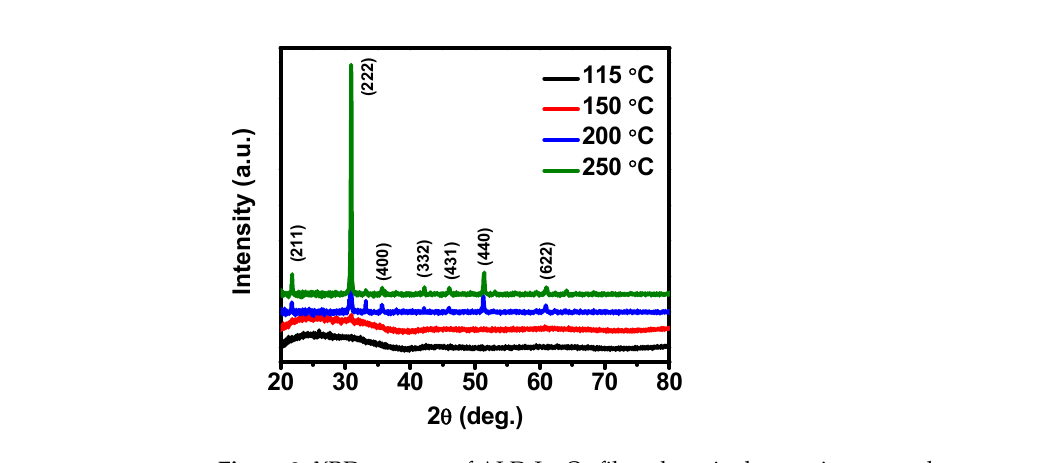
Figure 2. XRD patterns of ALD-In 2 O 3 films deposited on various growth temperatures. The crystallite size ( D ) of the In 2 O 3 thin films grown at 200 and 250 °C were calculated using the line broadening of the full width of half maximum (FWHM) of (222) prominent peak and the well-known Debye-Scherer formula (Equation (4)) [36].